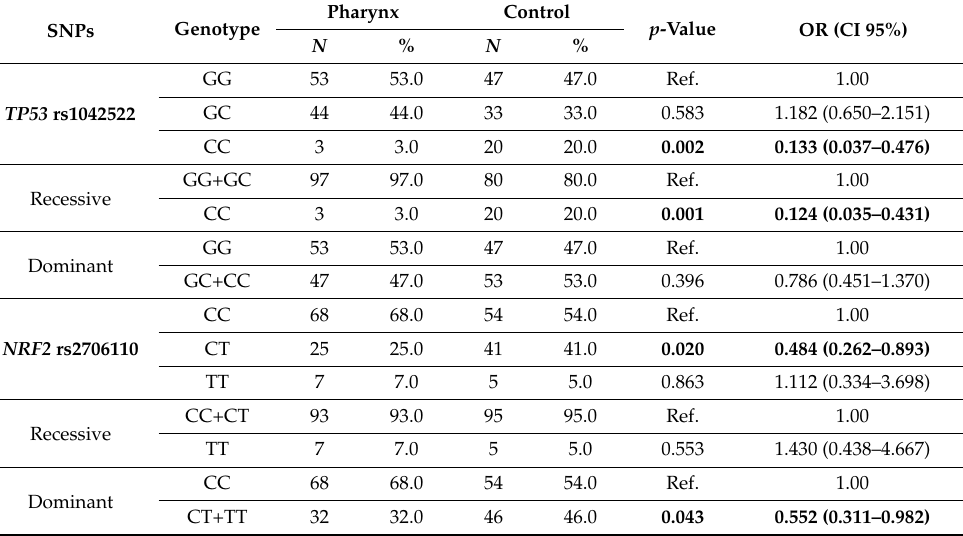
Table 4. Statistically significant SNPs in pharyngeal